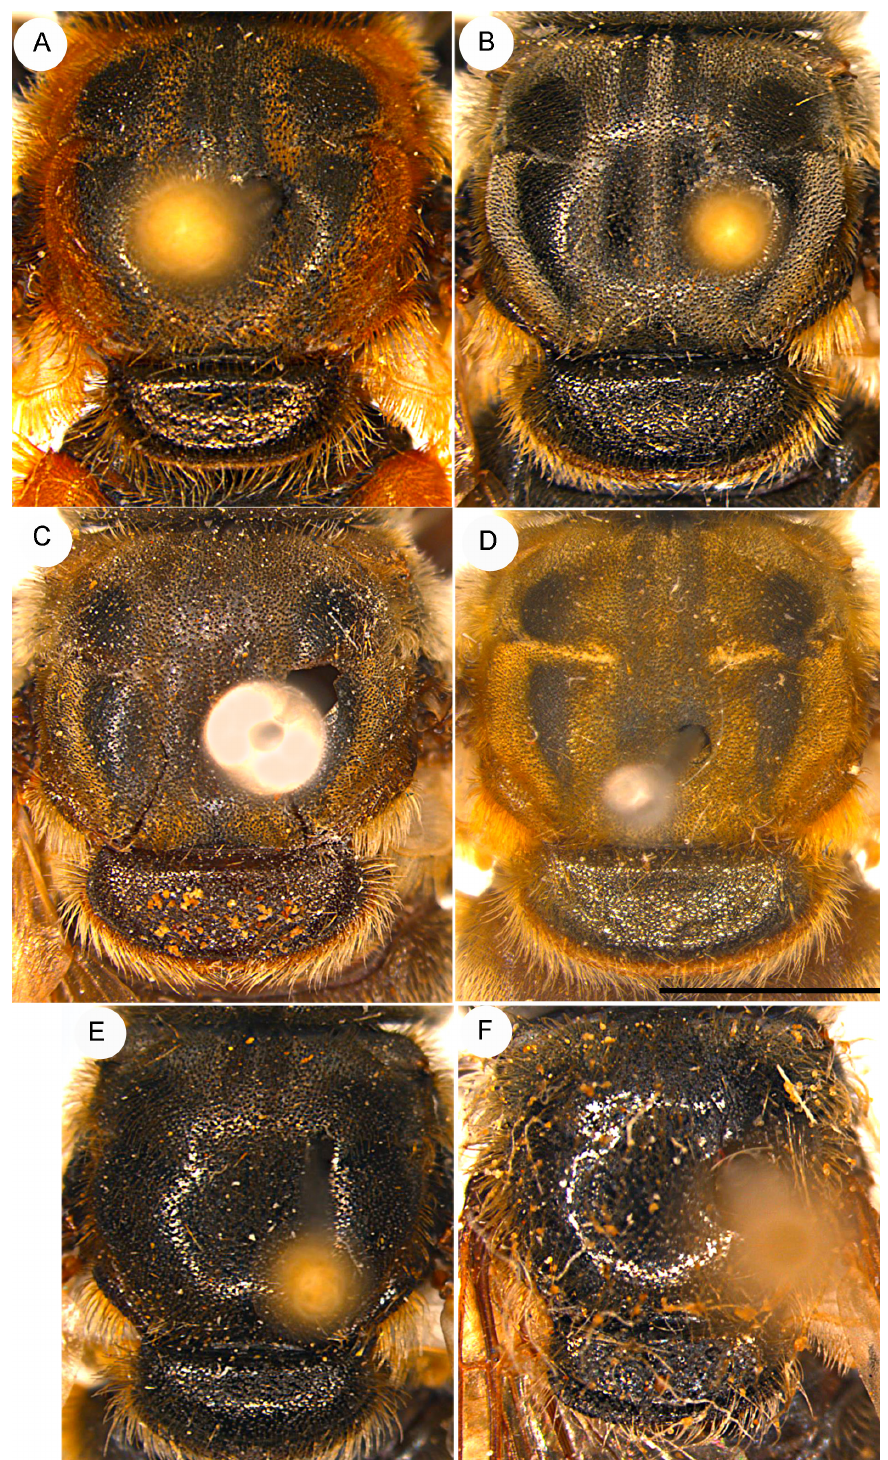
Fig. 10. Mesonotum, dorsal view. A . Merodon bombiformis Hull, 1944 (FSUNS; FSUNS ZA2_079). B . M. multifasciatus Curran, 1939 (FSUNS; FSUNS ID ZA5_243). C . M. vittatus Vujić & Likov sp. nov., holotype (NBCN; FSUNS ID 04085). D . M. zebra Vujić & Radenković sp. nov., paratype (RMCA; FSUNS ID 25090). E . M. lotus Vujić & Radenković sp. nov., paratype (FSUNS; FSUNS ID ZA6_066). F . M. nasicus Bezzi, 1915 (TAUI; FSUNS ID 04972). A, C, E-F . Male. B, D . Female. Scale bar = 2